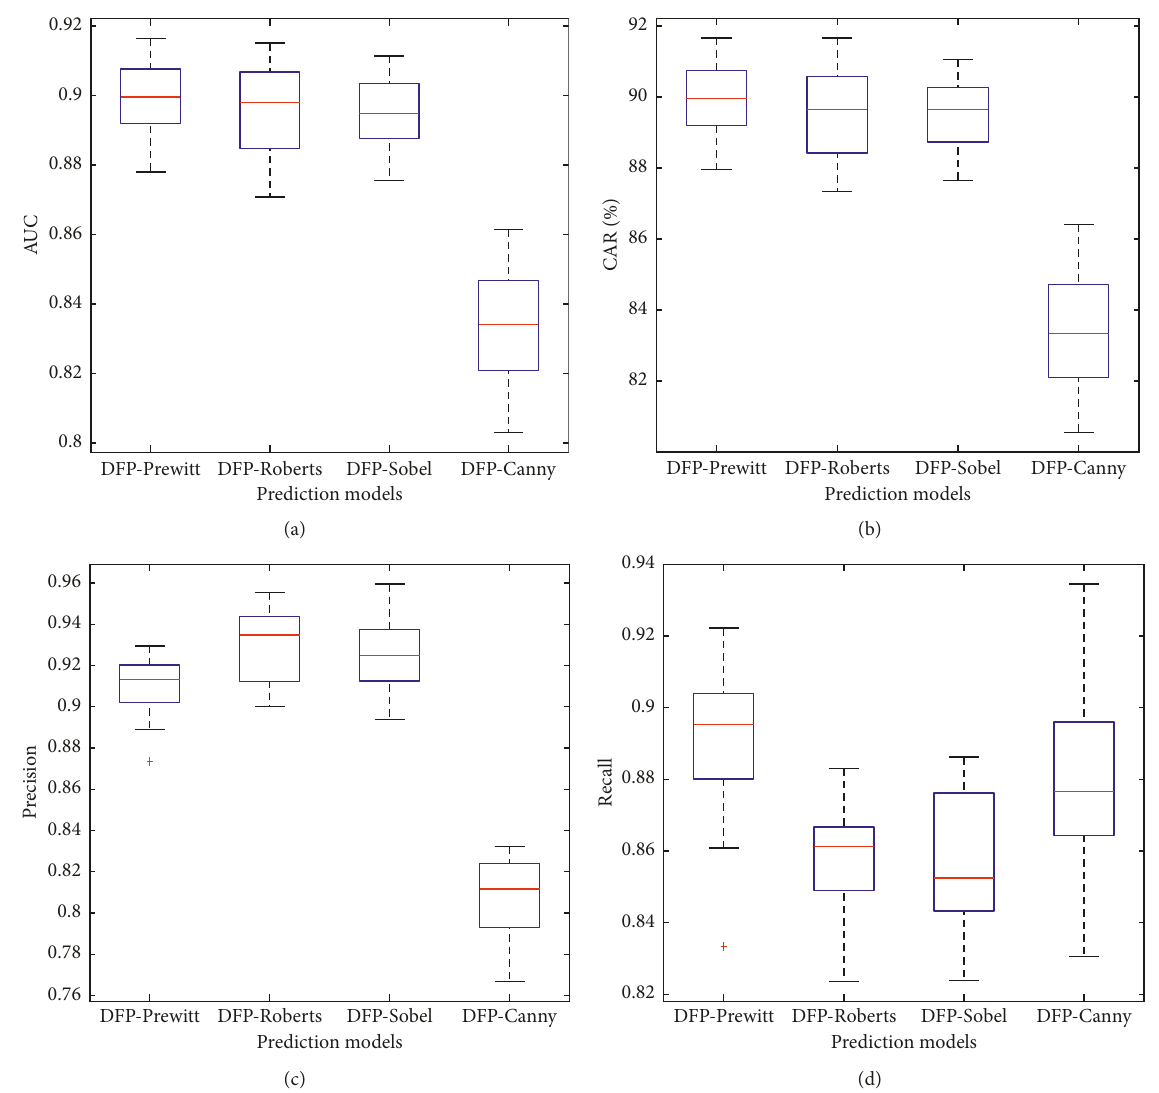
Figure 10: Model performance comparison in terms of (a) AUC, (b) CAR, (c) precision, and (d)